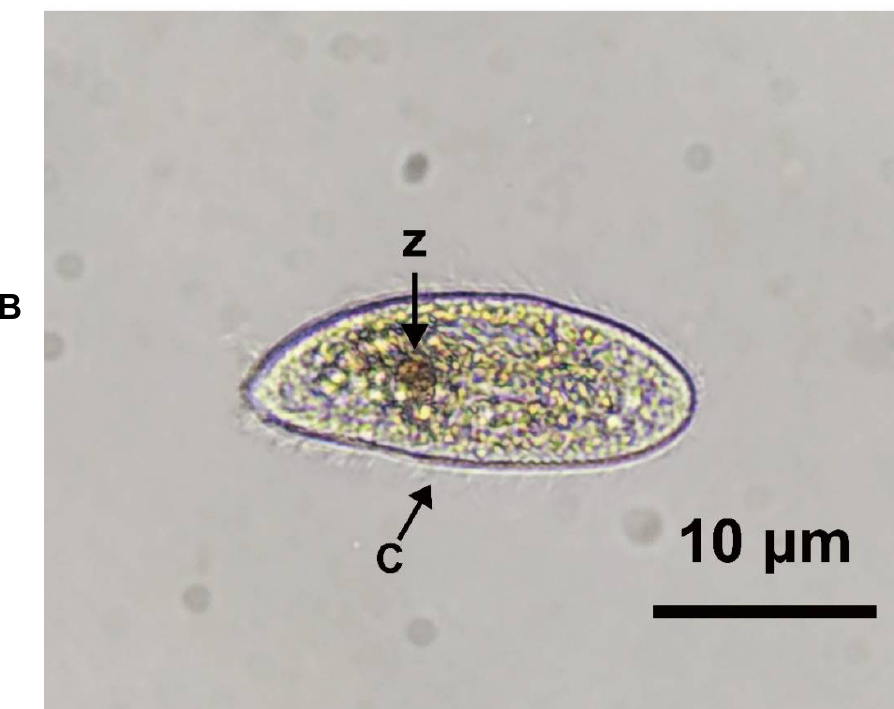
Figure 1. Ciliate morphology (magnification 400 × ). ( A ): P. Lucinda , which was extracted from coral, was in the body full of zooxanthellae with a body length of 170–200 µ m and a body width of 30–40 µ m. Cilia (C), zooxan thellae (Z). ( B ): No zooxanthellae were found in the body without feeding, and the body length was approximately 50–70 µ m, while the body width was 30–40 µ m. Cilia (C), zooxan thellae (Z).